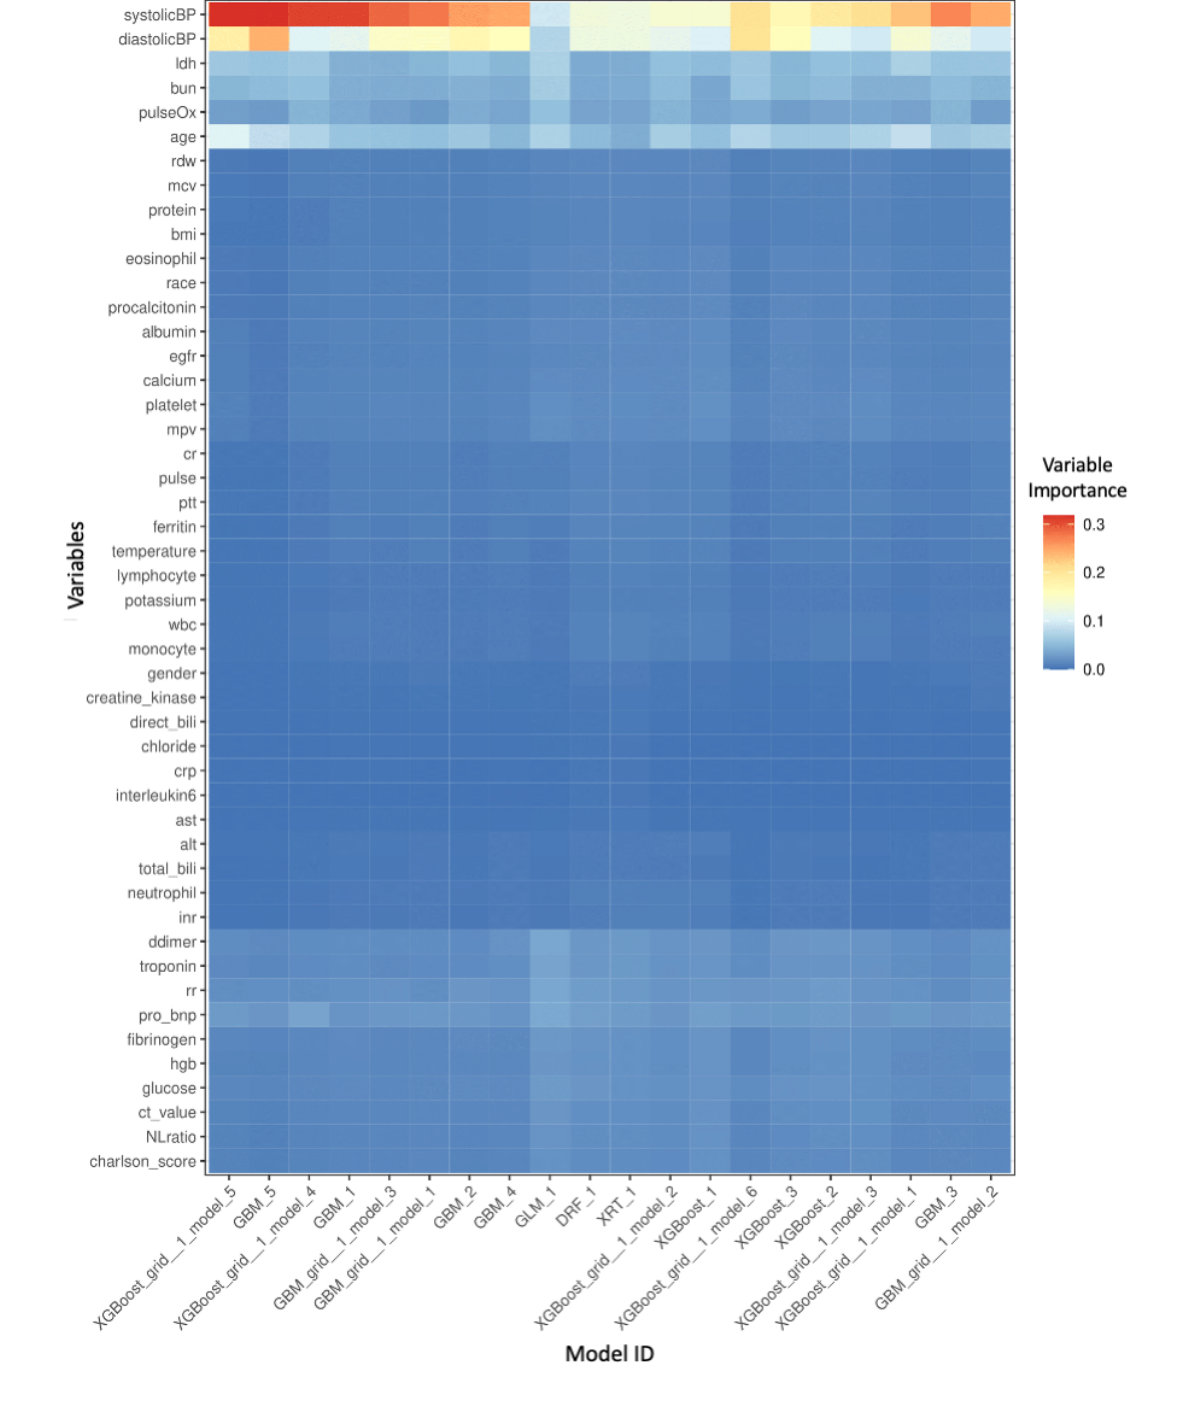
Selection of the Top 10 Variables: Dimensionality